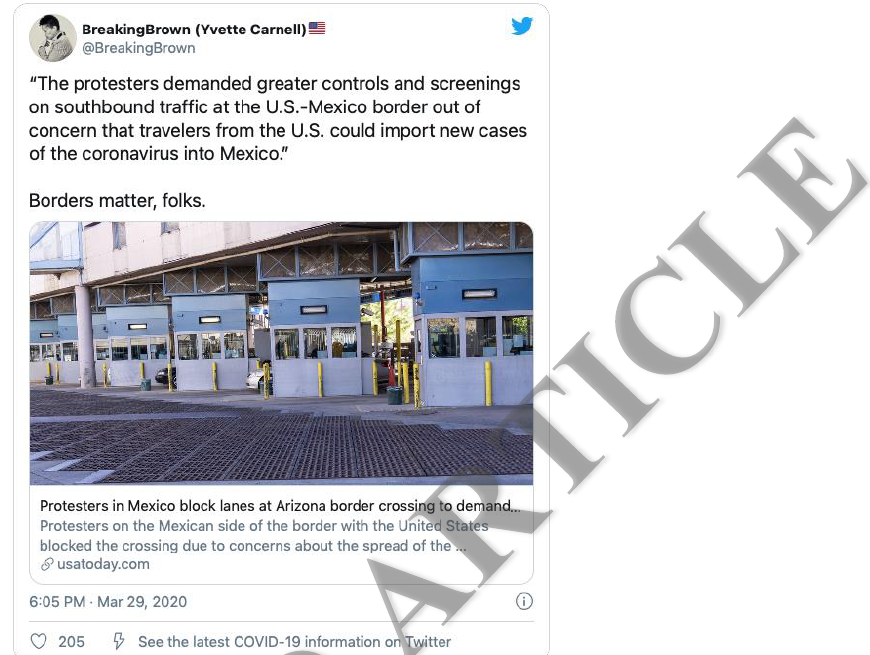
Figure 2. A tweet from Yvette Carnell on March 29, 2020, linking to a USA Today news story about conservative protestors linking disease spread and immigration